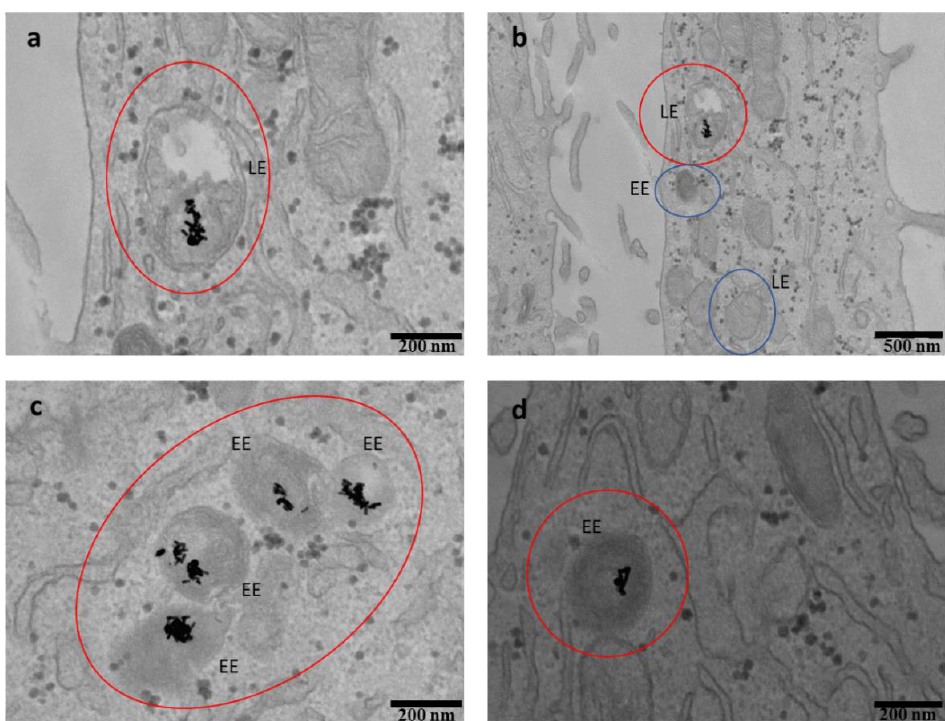
Figure 8. TEM images of HeLa cells after treatment with AuNR-BSA-r 8 incubated for 24 h ( a – d ). Red circles show the internalized AuNPs. EE: early endosomes and LE: late endosomes. Blue circles showing examples of vacant LE or EE.